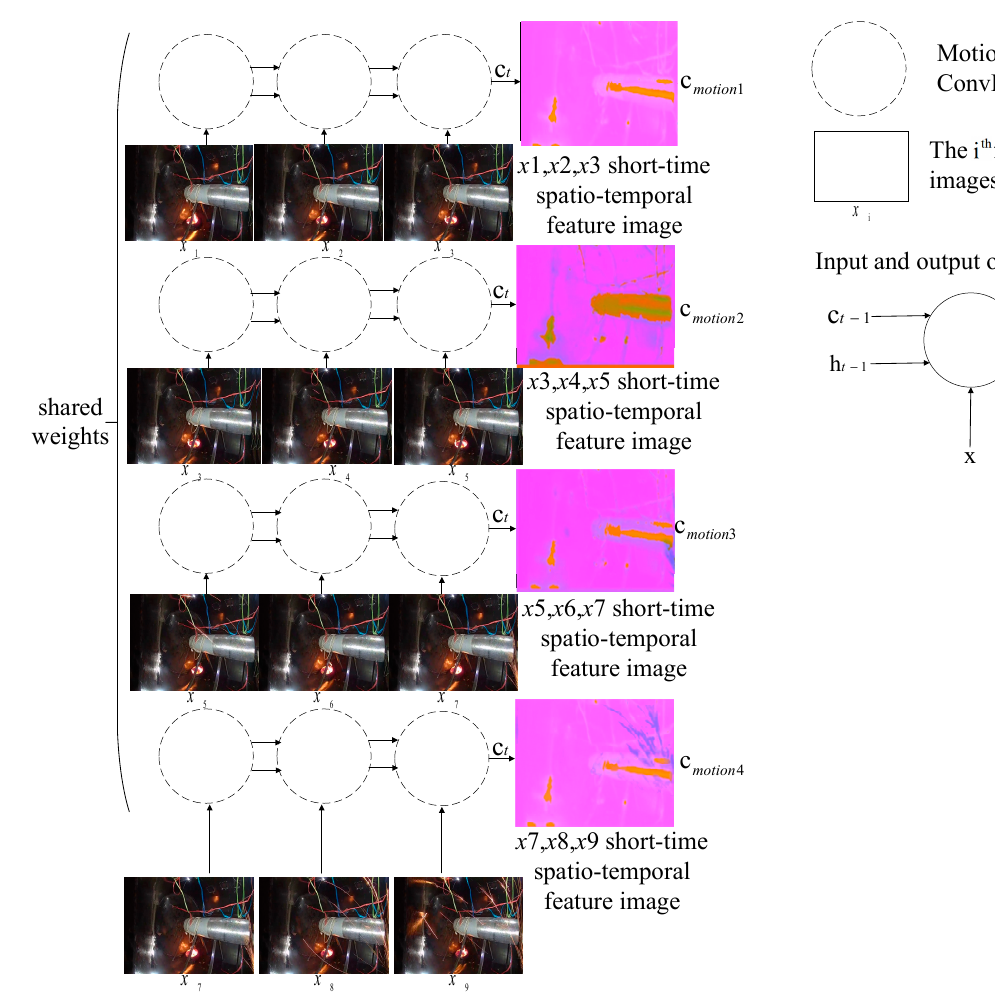
Figure 4. The proposed motion encoding model.